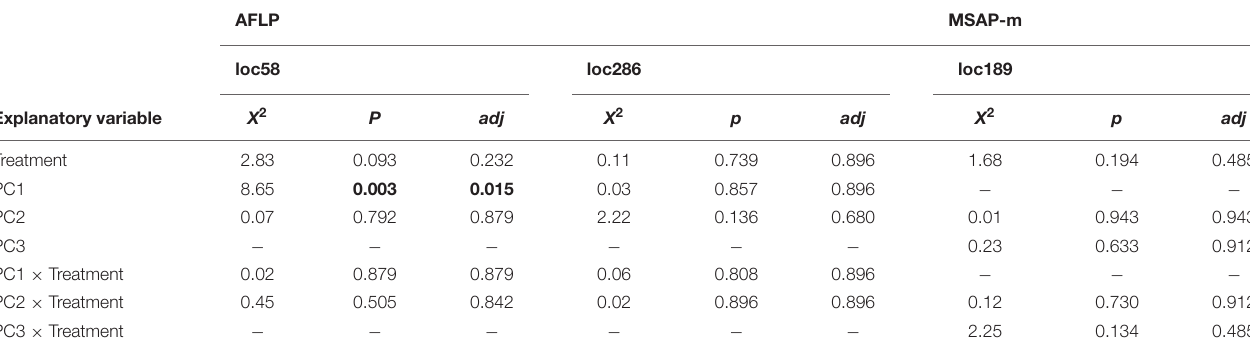
FIGURE 4 | Probability of genetic (AFLP) and epigenetic (MSAP-n) outlier loci for S. canadensis along climatic (WorldClim-PCA) and spatial genetic autocorrelation (MEMGENE) gradients. Outlier loci (see Supplementary Method 3 ) were analyzed with logistic mixed-effects models followed by likelihood-ratio tests ( Tables 3 , 4 ; significance levels: ** p < 0.01; * p < 0.05; n.s., not significant). Individual responses per group (control: black; zebularine treatment: orange) are given as rugs at the bottom (loci absent) and at the top (loci present). Predicted marginal-effect values are indicated by different line types (dashed—main effect significant; solid—effect of interaction with the zebularine treatment significant). (A) Genetic outlier locus (loc58; Supplementary Table 3 ) analyzed with a model including principal components, zebularine treatment, and the interaction with zebularine treatment as fixed factors. (B) Epigenetic outlier locus (loc135; Supplementary Table 4 ) analyzed with a model including MEMGENE variables, zebularine treatment, and the interaction with zebularine treatment as fixed factors. TABLE 3 | Summary of likelihood-ratio tests from logistic mixed-effects models applied to outlier loci detected jointly via the genome-scan approaches B AYE S C E NV and LFMM. AFLP